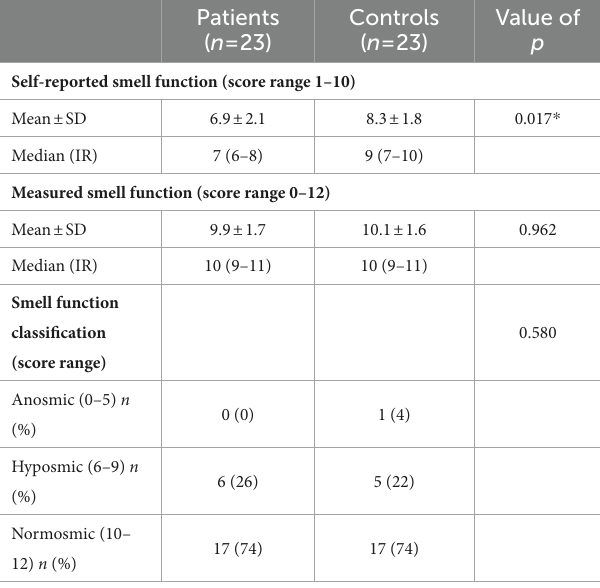
TABLE 6 Results and classifications of smell function measurements.